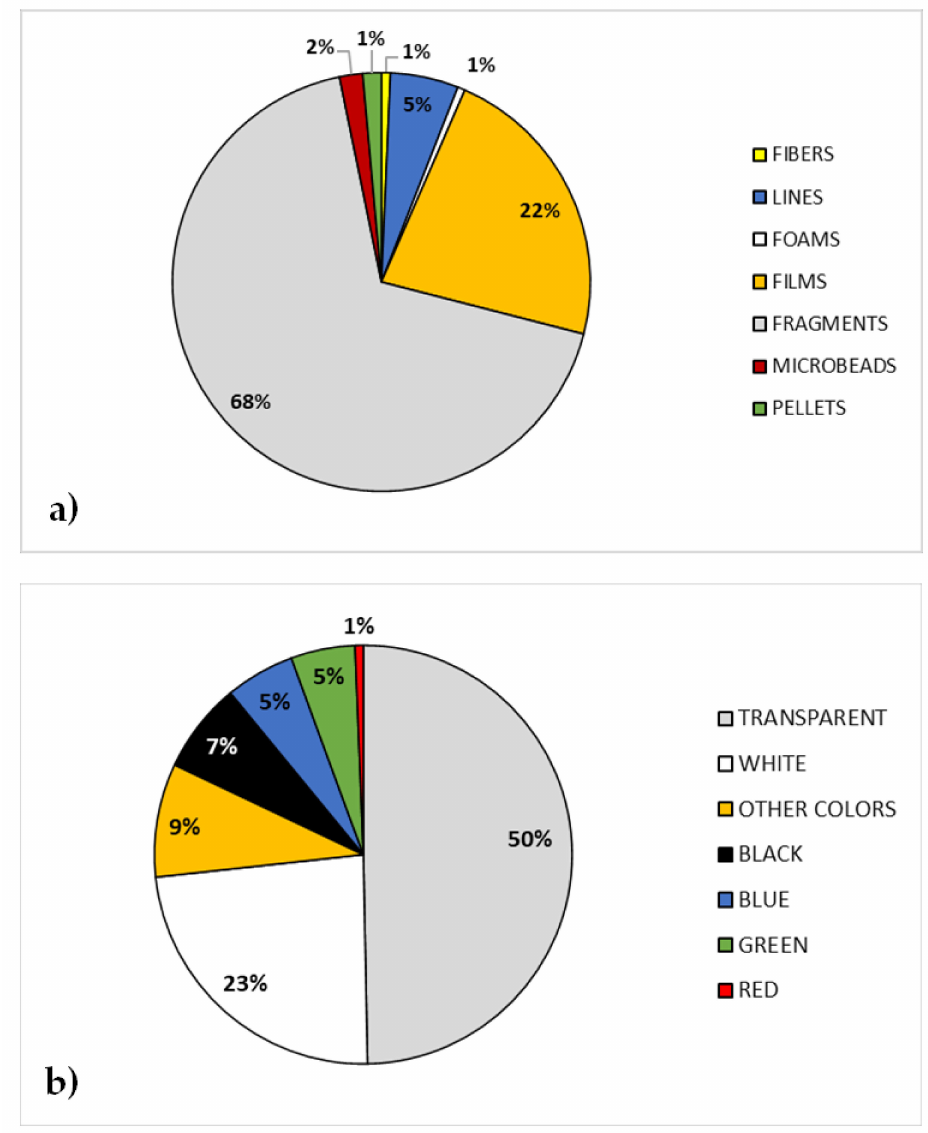
Figure 4. Shape ( a ) and color ( b ) of microplastics in the center of the Mediterranean Sea. MPs occur in a range of colors [41]. MPs’ color is not a secondary factor for their threat to marine life, as the color affects the interaction with marine organisms—some colors seem to affect the ability to distinguish between plastics and their natural food [42,43]. Aquatic organisms ingest MPs together with their food, deceived by their size and especially by their color; indeed, small plastic fragments have been reported in several species and in all phases of the marine food chain [44–46]. According to literature data, transparent and white were the most common particles in our sampling and accounted for 50% and 23%, respectively, whereas colorful plastics (black, blue, green, red, and other colors) accounted for the remaining 27% (Figure 4b). Therefore, our results showed a very high percentage of MPs with color characteristics (73%) that promote their entry into the food chain of aquatic organisms. An important source of these types of particles (transparent and white) might be plastic bags, extensively used in daily life. Furthermore, this prevalence of colorless particles could also be due to the loss of color that many colored particles, especially some lines and films, undergo once they enter the surface waters. In turn, some white plastics had turned pale yellow and, not surprisingly, showed rounded corners, due to environmental exposure over a long period of